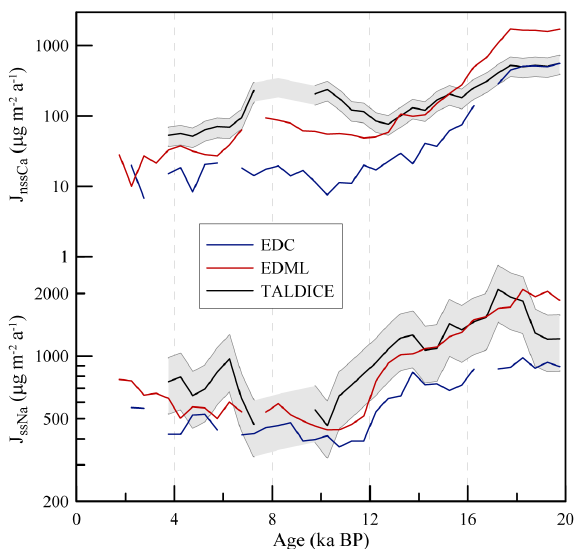
Fig. 4. NssCa 2 + ( J nssCa ) and ssNa + ( J ssNa ) fluxes for the Holocene and T1. The grey shaded bands indicate the range covered by the estimated 30% error as mentioned in Sect. 2.3. In TALDICE, they show opposite trends during the deglaciation and early–mid- Holocene (i.e.